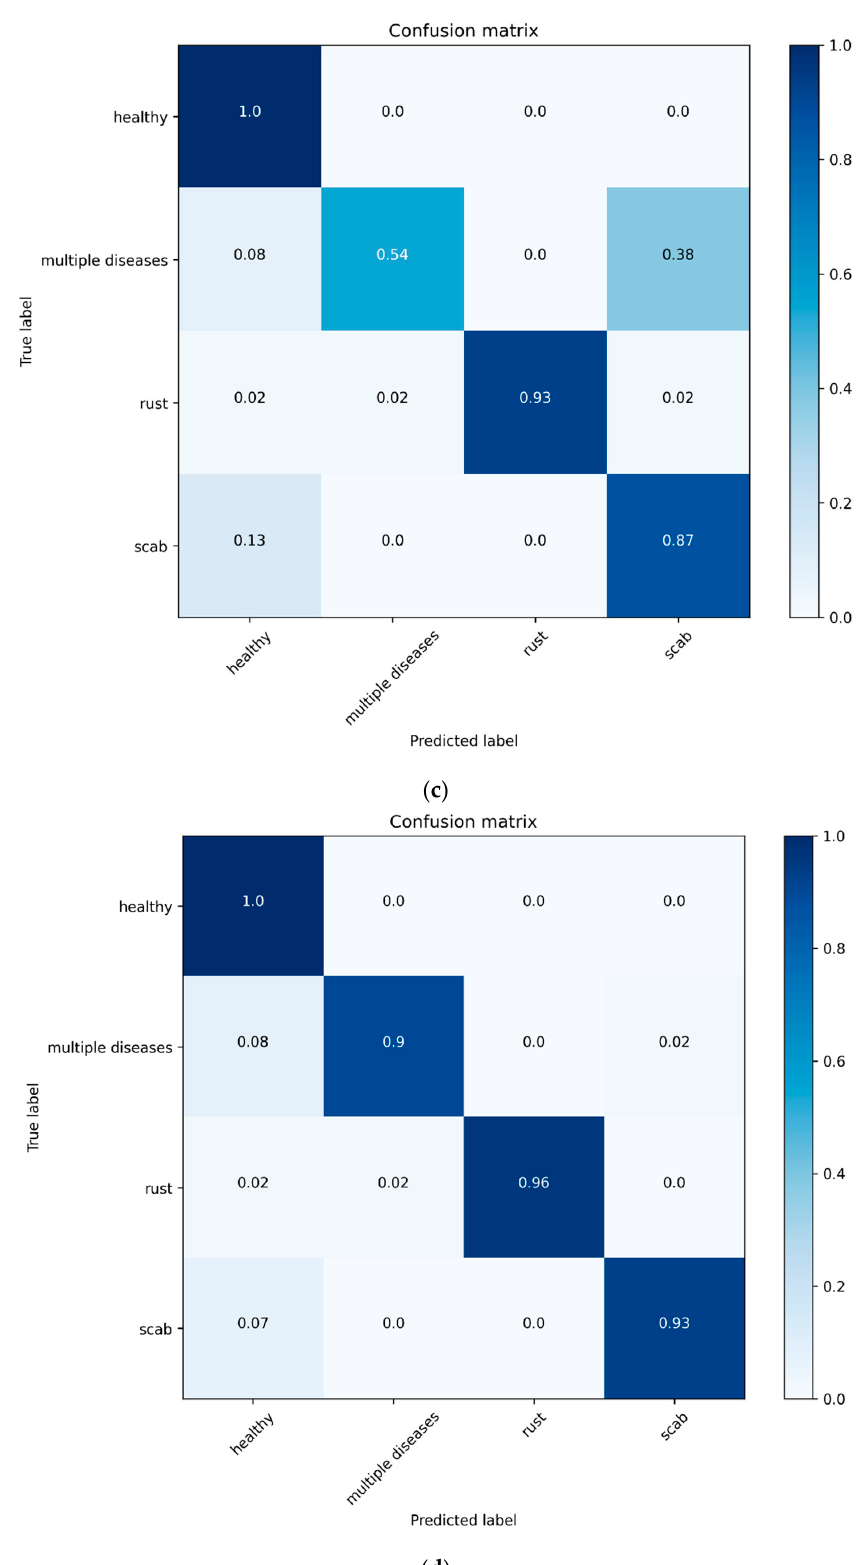
Figure 25. Confusion matrices for pre-trained and proposed model. ( a ) Confusion matrix for DenseNet121; ( b ) confusion matrix for EfficientNetB7; ( c ) confusion matrix for NoisyStudent; ( d ) confusion matrix for our proposed model.